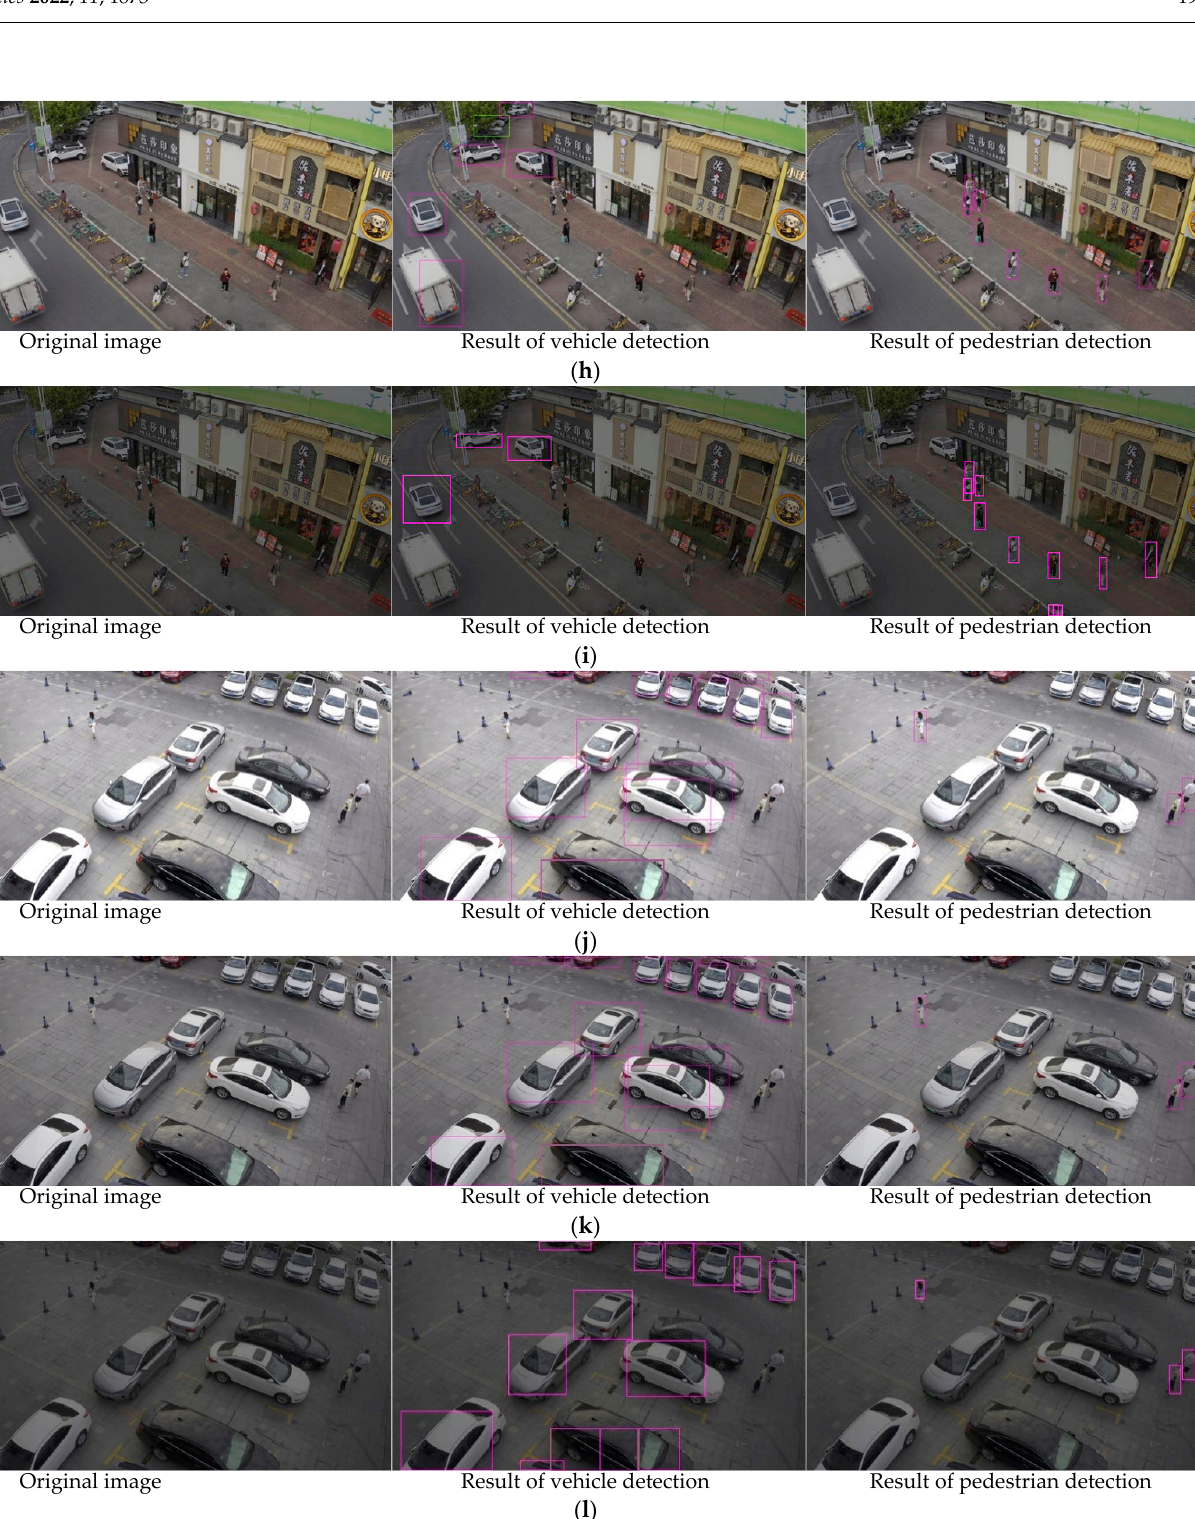
Figure 7. Ground vehicle and pedestrian detection results of proposed method using images with same scene but different environment luminance. ( a–c ) are the original images and their luminance degradation results. ( d–f ) Original images and detection results of ( a1 ), ( a2 ) and ( a3 ), respectively. ( g–i ) Original image and detection results of ( b1 ), ( b2 ) and ( b3 ), respectively. ( j–l ) Original image and detection results of ( c1 ), ( c2 ) and ( c3 ), respectively.